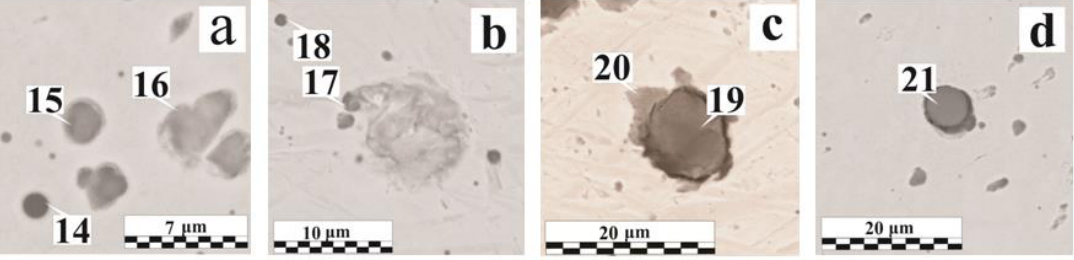
Figure 6. Nonmetallic inclusions in welds: ( a , d ) with OS-56-22, 185 µ m; ( b , c ) with OS-82-01, 160 µ m. The presence of the OSCs breakdown refractory products in a supercooled liquid